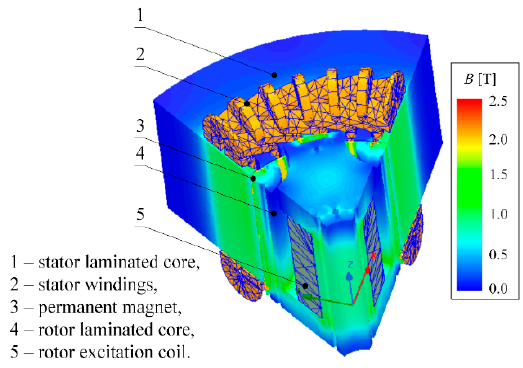
Figure 19. FEA model of HECPMLR [58].